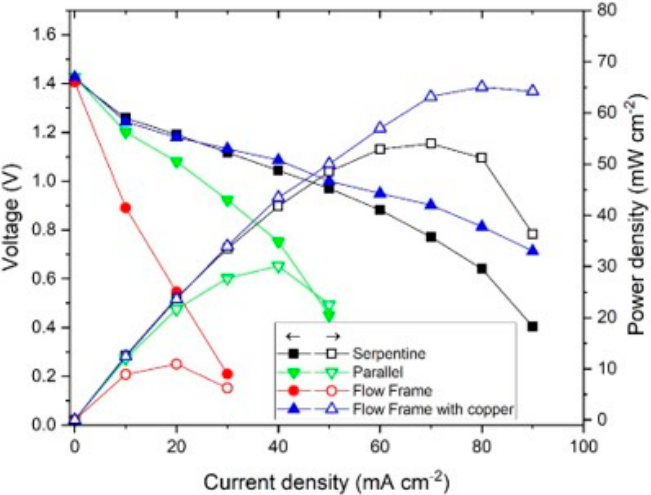
Figure 3. Polarization (solid symbols) and power density (open symbols) curves of the different flow fields.